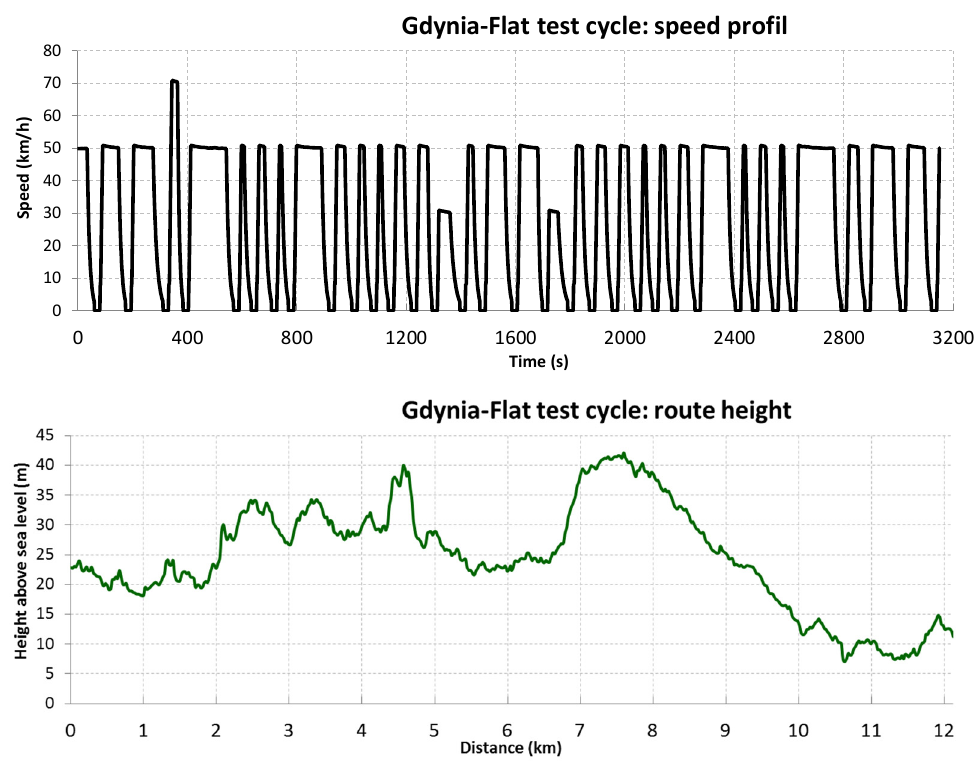
Figure 12. Gdynia-Flat route height and speed profiles.